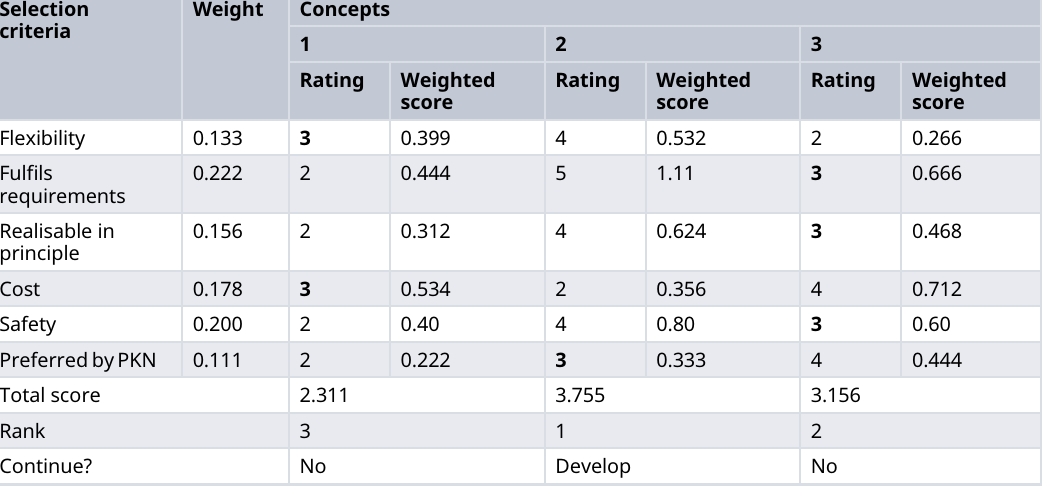
Table 10. The concept scoring